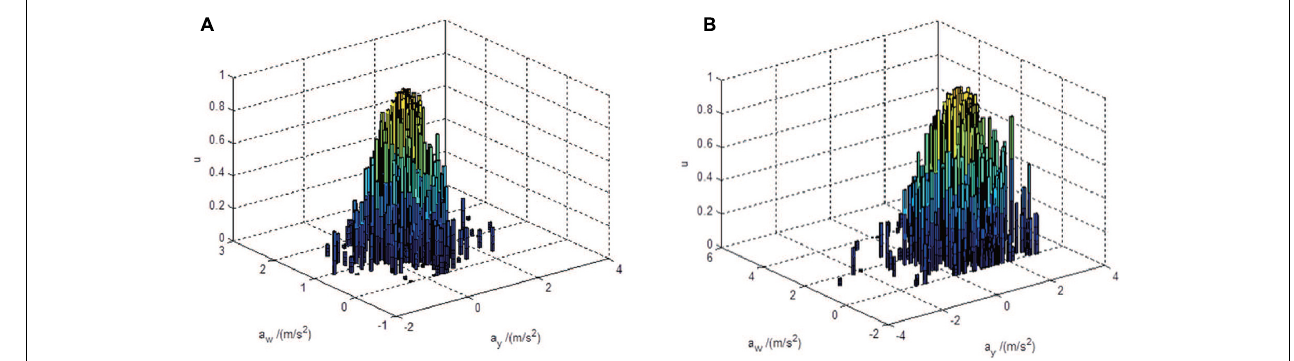
FIGURE 6 | 2D cloud model with different acceleration states: (A) Slow speeding; (B) urgent to acceleration.